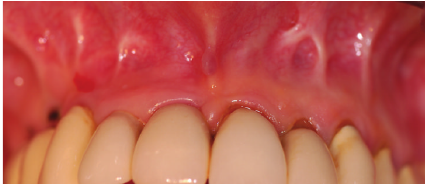
Figure 3: Oral view: scarred tissue in the vestibule of the upper jaw after surgery in